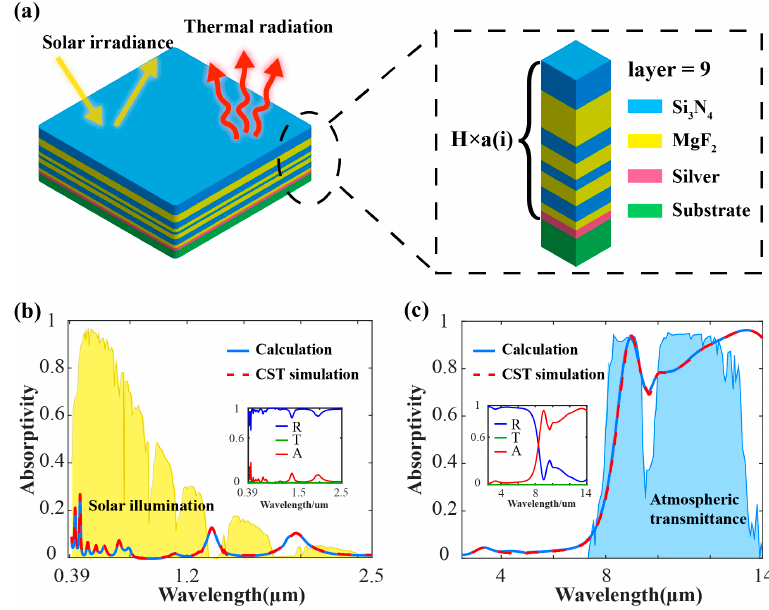
Figure 2. The results of optimized structure. ( a ) Schematic image of the radiative cooling coating with alternating MgF 2 and Si 3 N 4 layers; ( b ) calculated and computer simulation technology (CST) simulated absorptivity of the radiative cooling coating over visible and near-infrared wavelength ranges, with the AM1.5 solar spectrum plotted for reference. The coating reflects 95% of the incident solar radiation. The inset is the reflectivity(blue), transmittance (black) and the absorptivity (red) of the coating of 0.39–2.5 µ m; ( c ) calculated and CST simulated emissivity / absorptivity of the radiative-cooling coating over mid-infrared wavelengths, with the atmospheric transmittance plotted for reference. The coating emits 76% of the radiation over the mid-infrared atmospheric transparency window. The inset is the reflectivity (blue), transmittance (black) and the absorptivity (red) of the coating of 2.5–14 µ m. Table 1. Optimized parameters of the proposed structure and parameters of coating I and coating II. Number of Layers Layer = 9 Total Thickness H = 1.495 µ